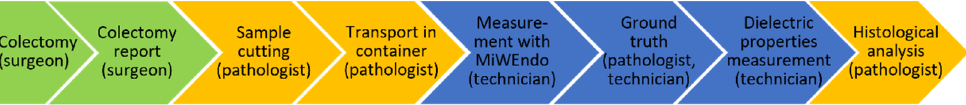
Figure 3. Protocol for the acquisition of electromagnetic measurements within medical routine.